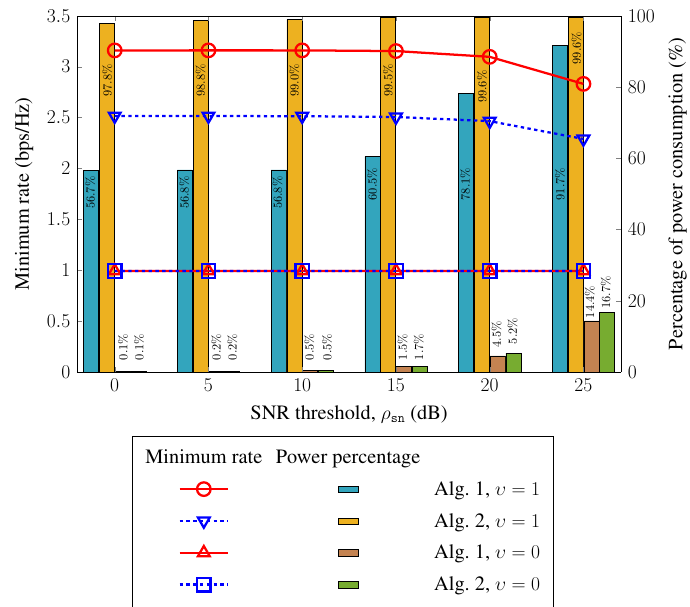
Figure 7. Minimum rate and percentage of power consumption versus SNR